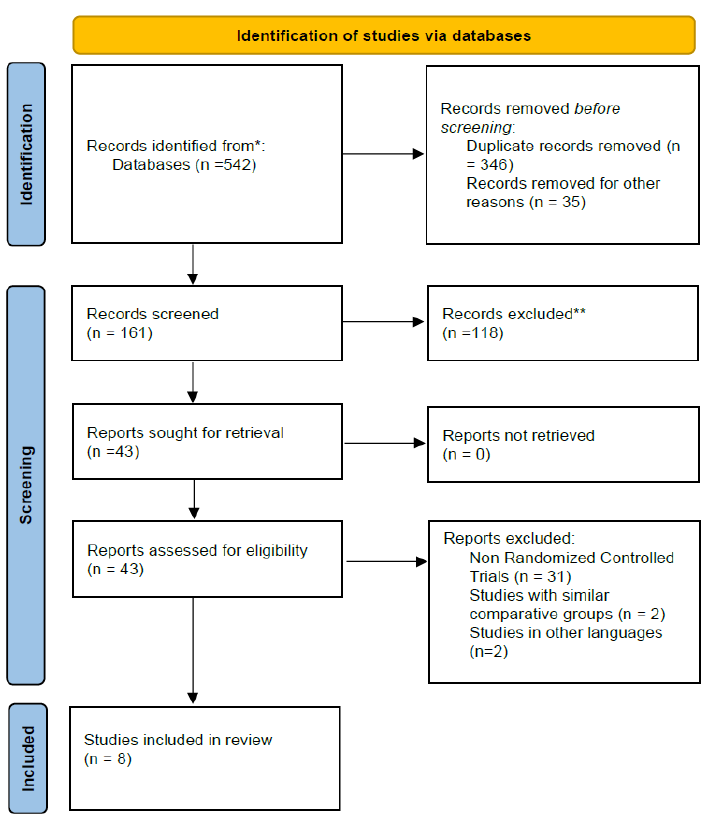
Figure 1. Flowchart showing the process of data collection and analysis.